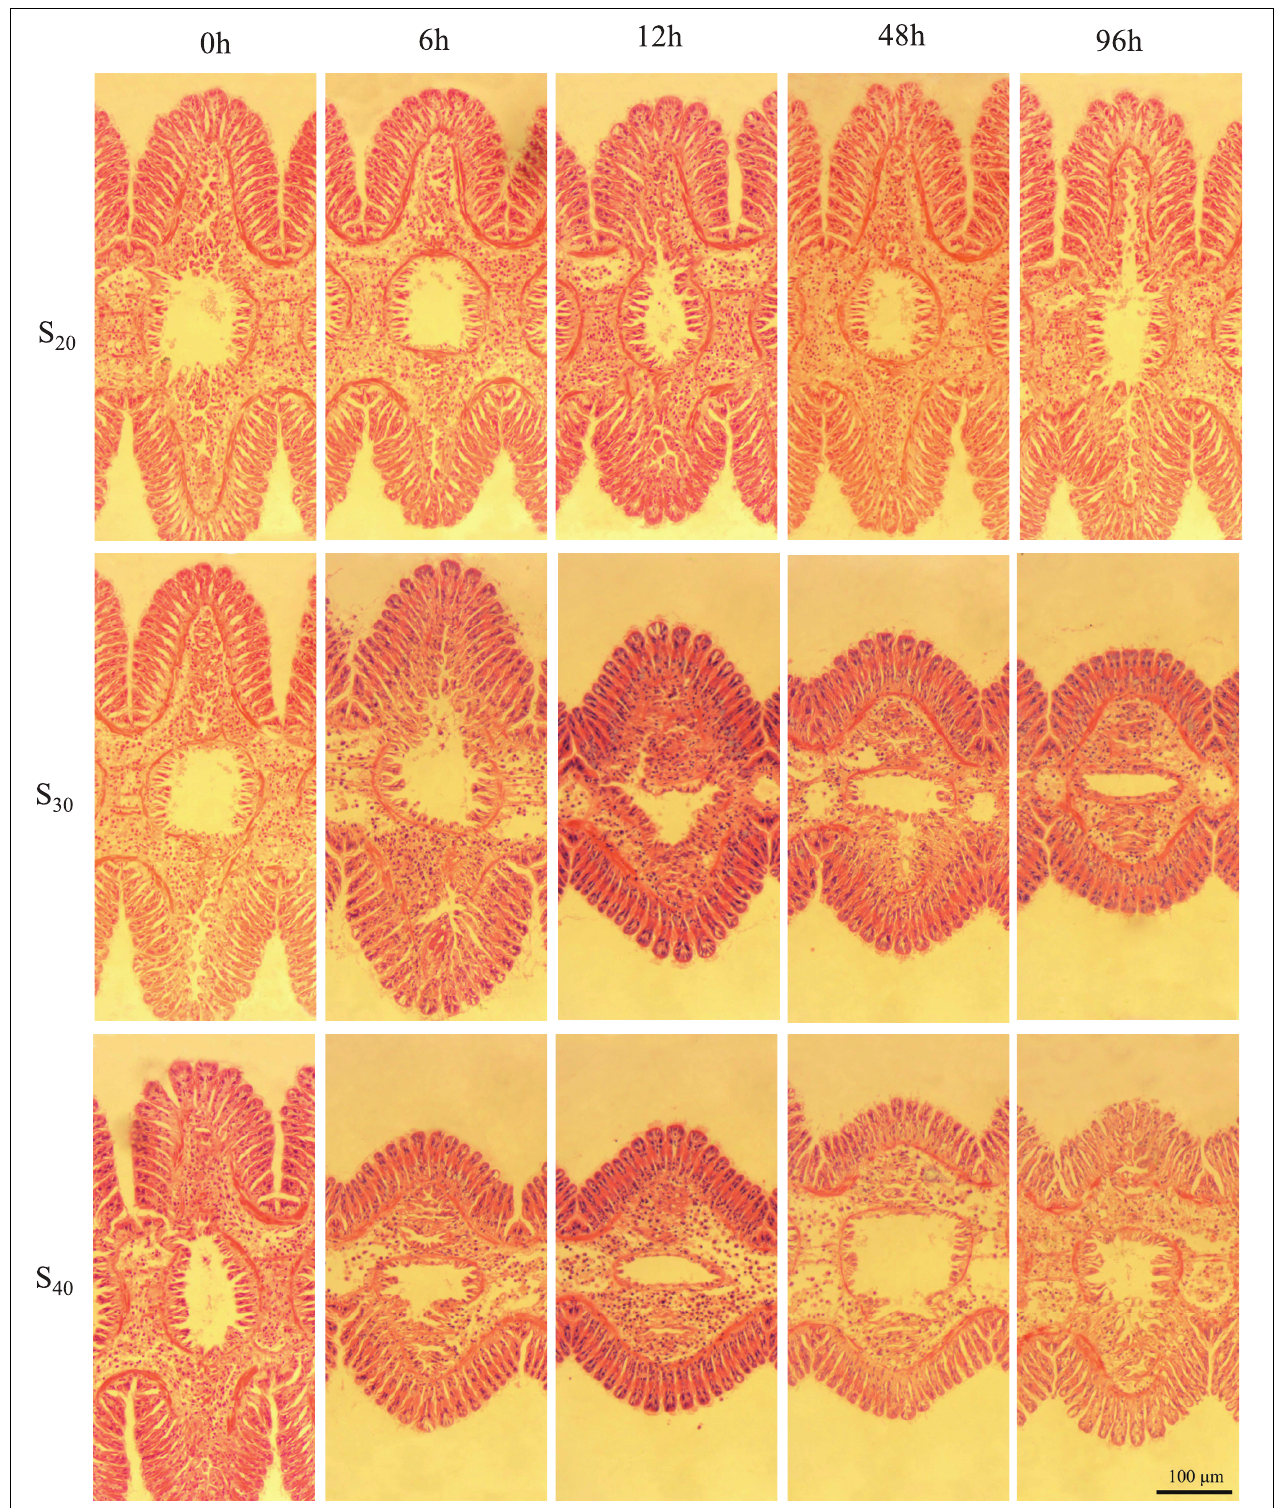
FIGURE 3 | Gill tissue structure of Sinonovacula constricta at different salinities and time points. S 20 : Control group; S 30 : salinity of 30 ppt; S 40 : salinity of 40 ppt. Scale bars are 100 µ m.